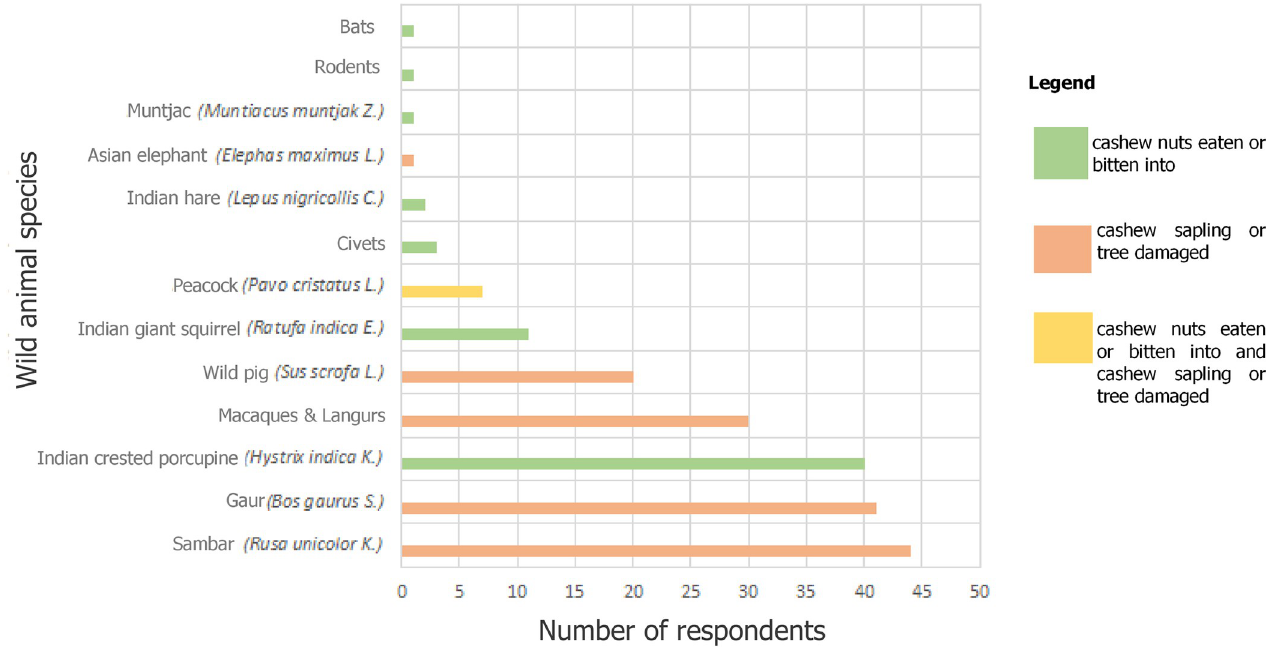
Fig 6. Wildlife reported to cause cashew crop loss and the nature of damage reported across 65